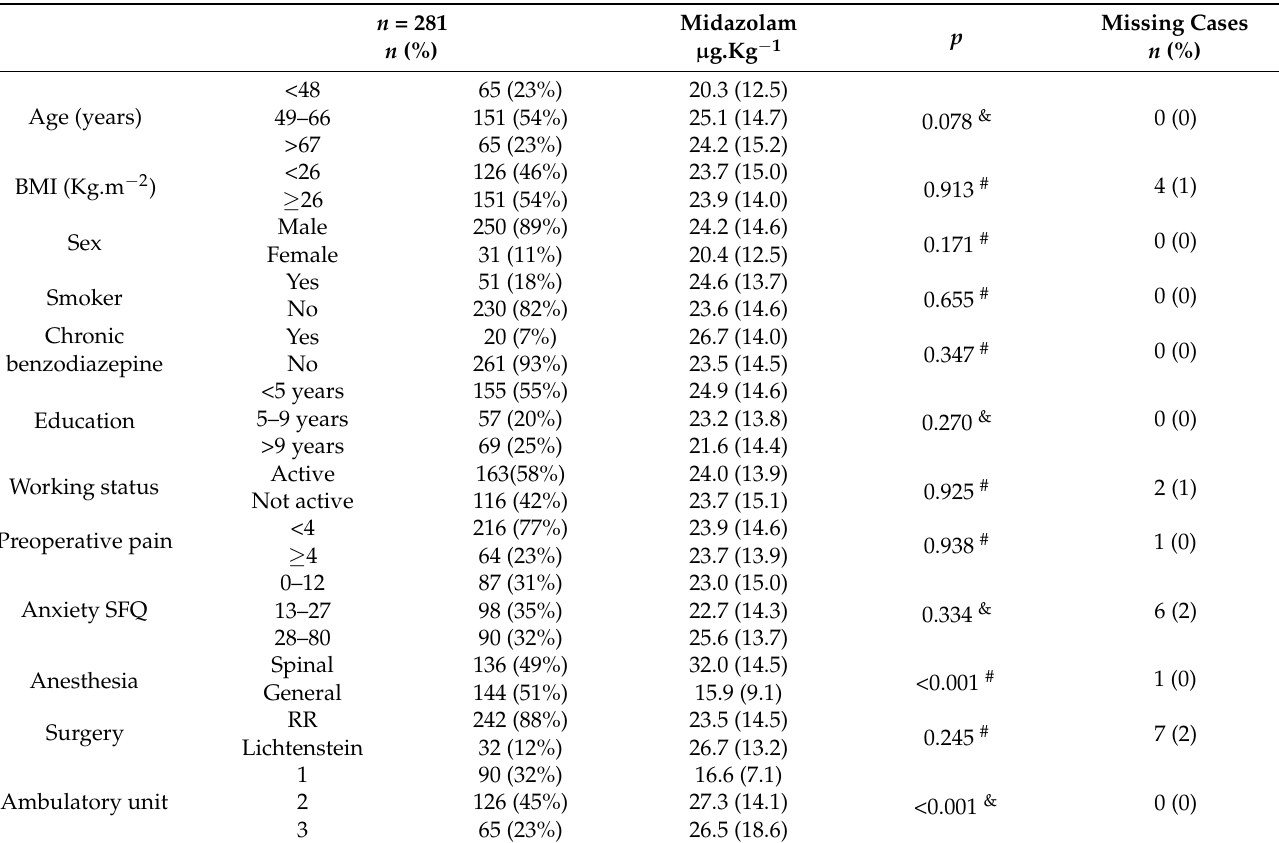
Table 1. Patient characteristics and mean midazolam doses for each